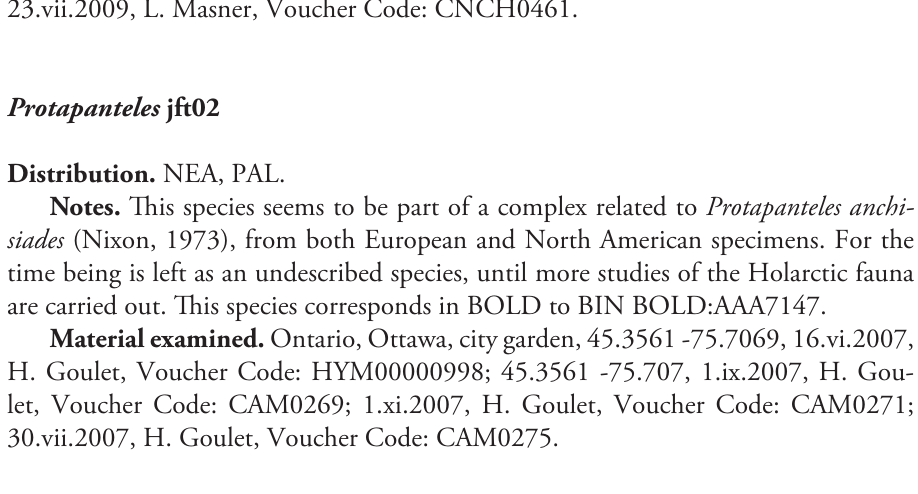
Distribution. NEA.